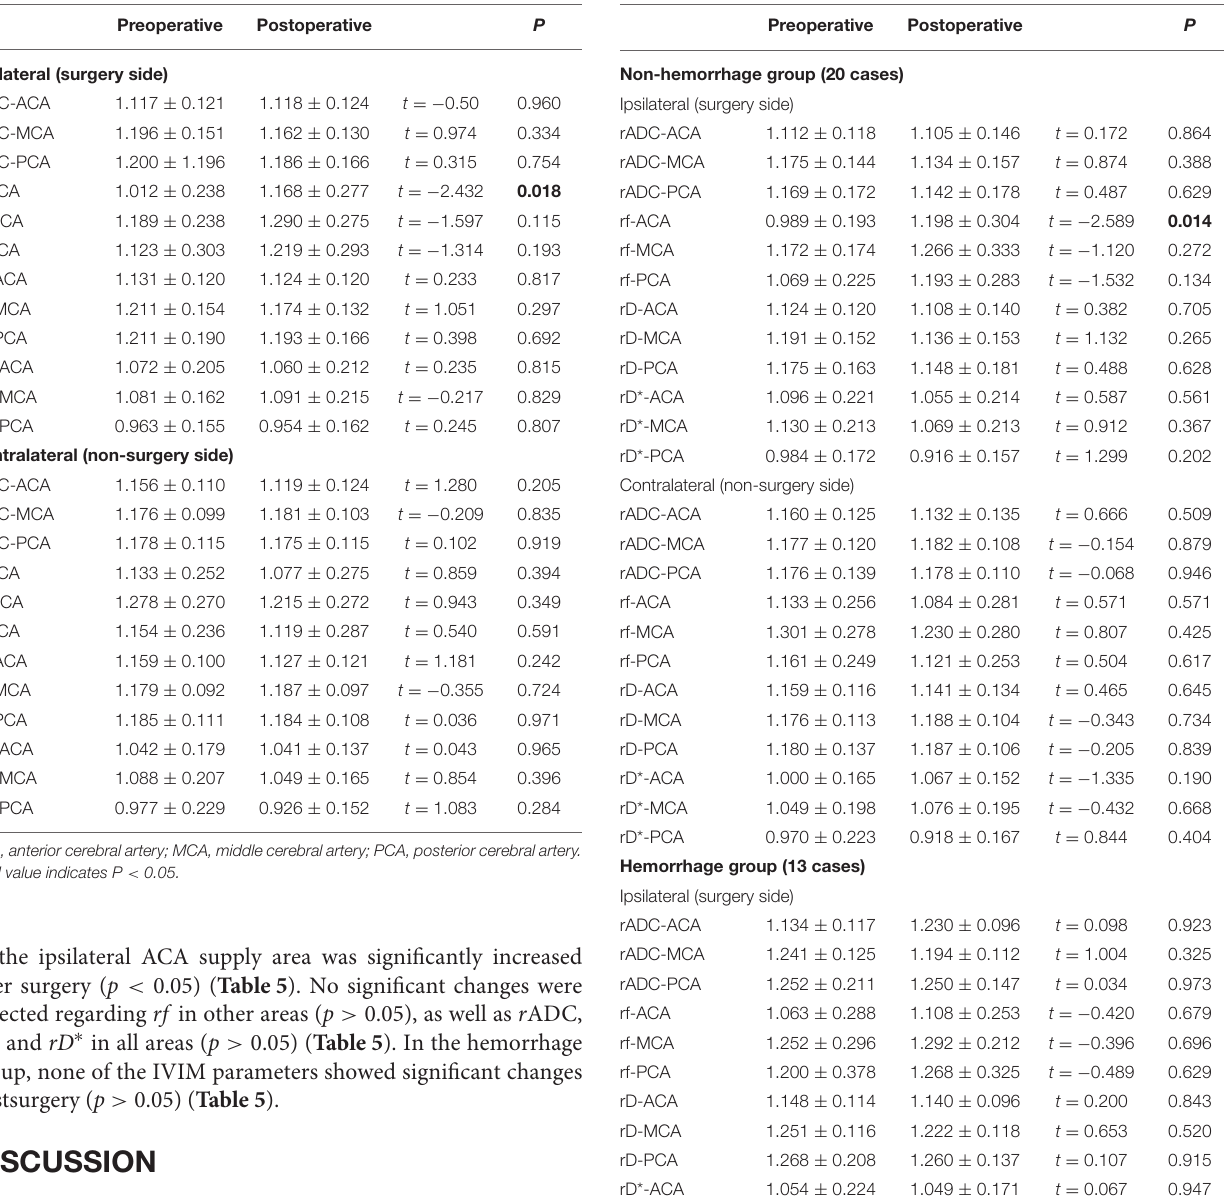
TABLE 5 | Postoperative microvascular perfusion changes of non-hemorrhage group (20 cases) and hemorrhage group (13